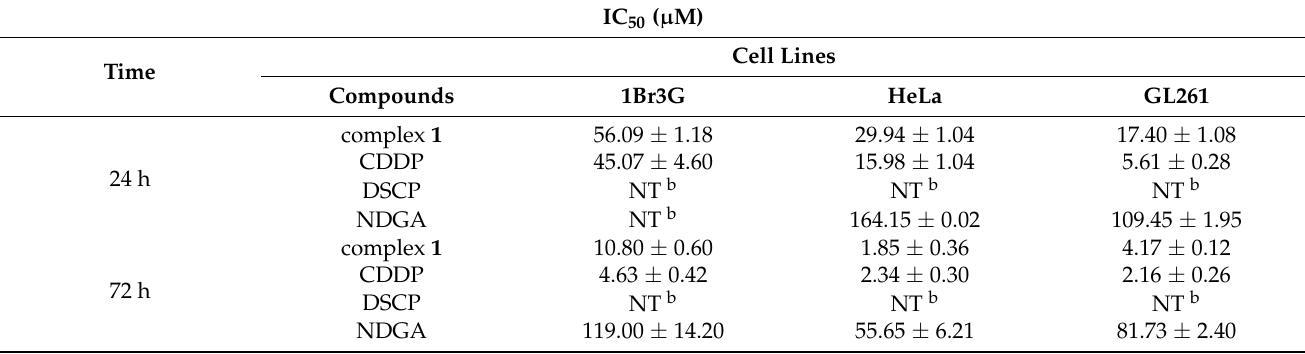
Table 1. IC 50 ( µ M) a of compounds against different murine and human cell